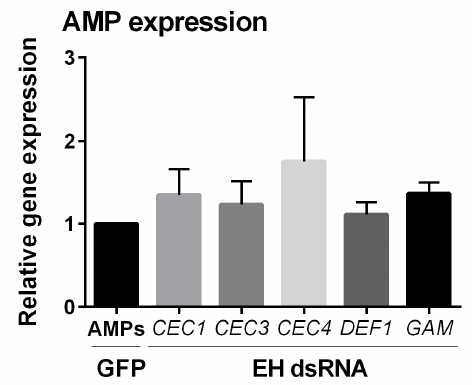
Figure 3. Epoxide hydrolase (EH)-silencing does not influence AMP expression. The effects of EH-silencing on anti-microbial peptide (AMP) expression were evaluated by qRT-PCR. Relative gene expression was compared between EH-silenced whole mosquitoes and that of green fluorescent protein (GFP) controls. Data were analyzed using an unpaired t-test to determine differences in relative gene expression of each respective AMP gene between GFP and EH dsRNA treatments. Bars represent mean ± SEM of three independent experiments. CEC1 (cecropin 1, AGAP000693), CEC3 (cecropin 3, AGAP000694), CEC4 (cecropin 4, AGAP006722), DEF1 (defensin 1, AGAP011294) and GAM (gambicin,